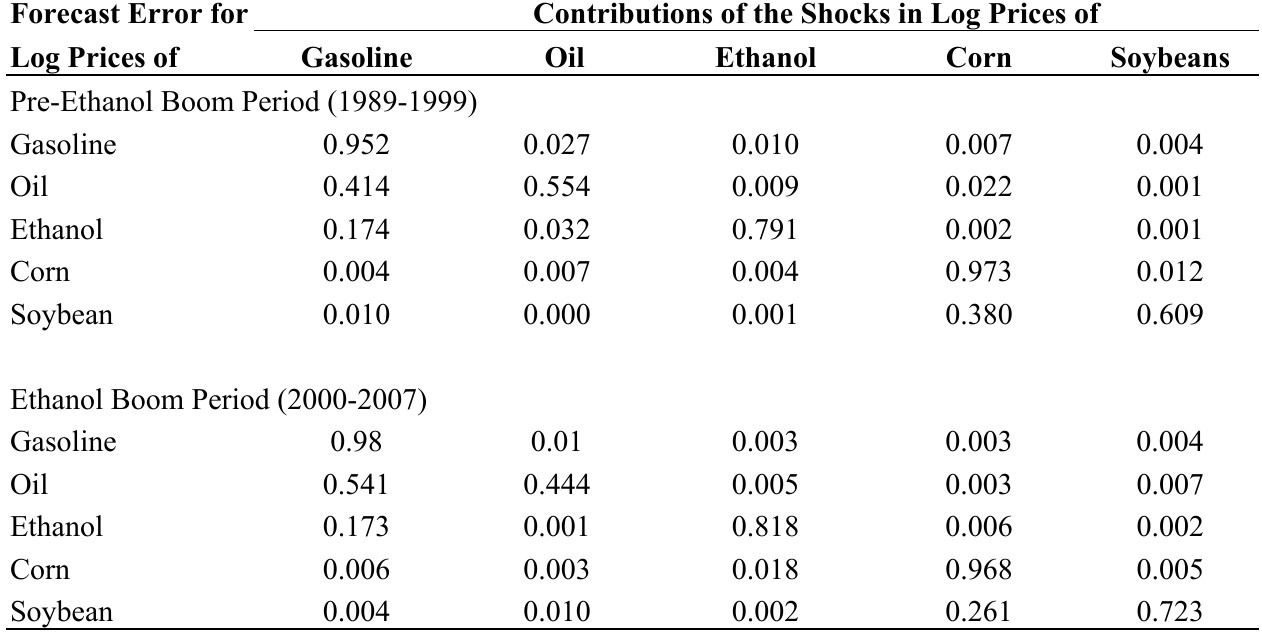
Table 5. Variance-Decompositions after Five Periods